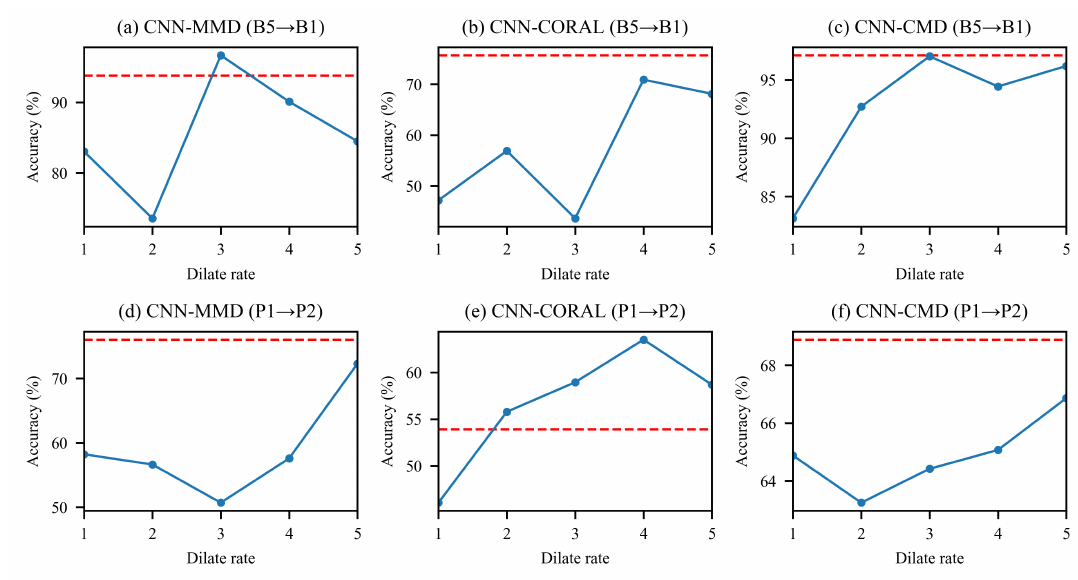
Figure 10. The accuracy under different dilation rates in the first layer of ordinary